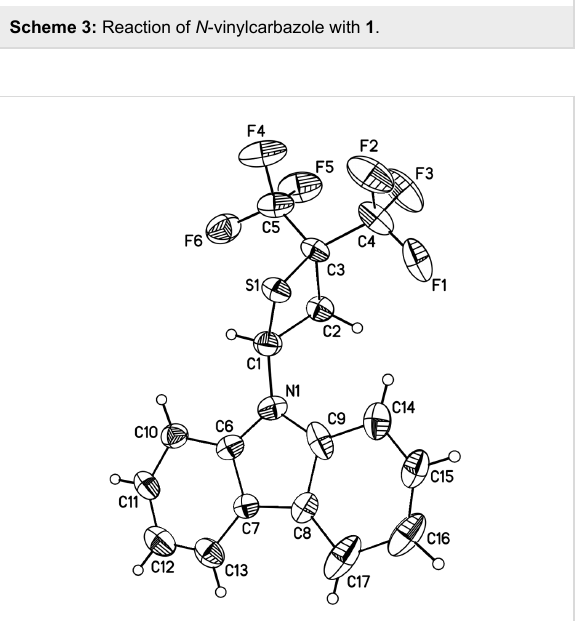
Figure 2: Crystal structure of 3e with thermal ellipsoids drawn at the 30% probability level. Disordered atoms are omitted for clarity.